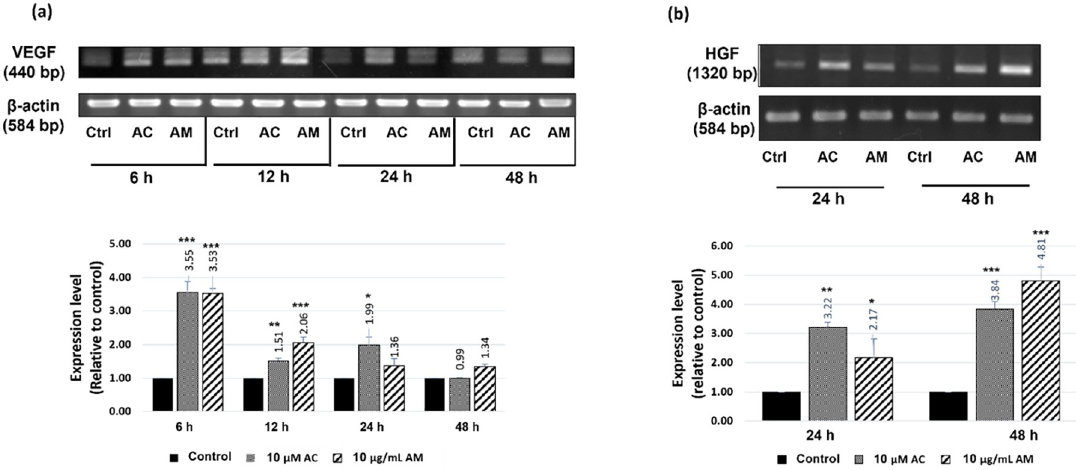
Fig 6. The effect of the AM extract (10 μ g/mL) and of the AC (10 μ M) on the gene expression of VEGF and HGF. DPCs were incubated with 30 μ M of T, and were treated with the AM extract or with AC at various times before determining the gene expression of (a) VEGF and (b) HGF. The expression levels of each of these growth factors were analyzed by using the ImageJ 1.53e software. All data were performed in triplicate, and are herein presented as mean ± SD (n = 3). * p < 0.05, ** p < 0.01, and *** p < 0.005 versus non-treated